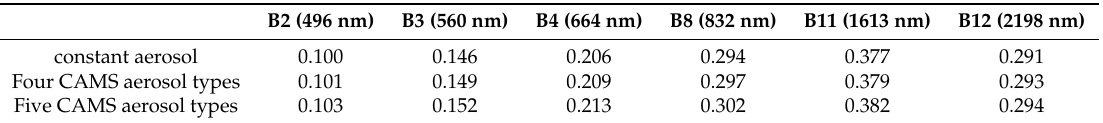
Table 12. MAJA (MACCS-ATCOR Joint Algorithm) average surface reflectances for arid sites. CAMS: Copernicus Atmosphere Monitoring Service.